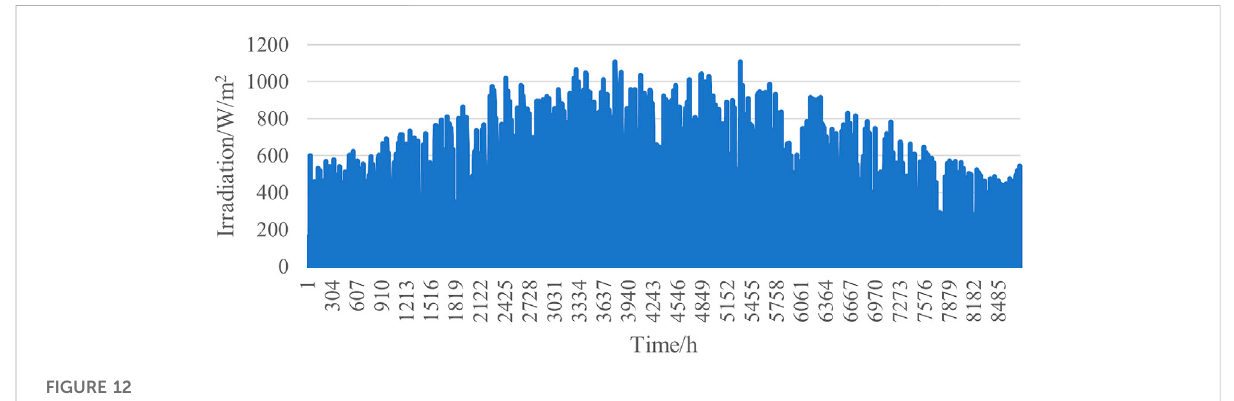
FIGURE 12 Irradiance of a site in a